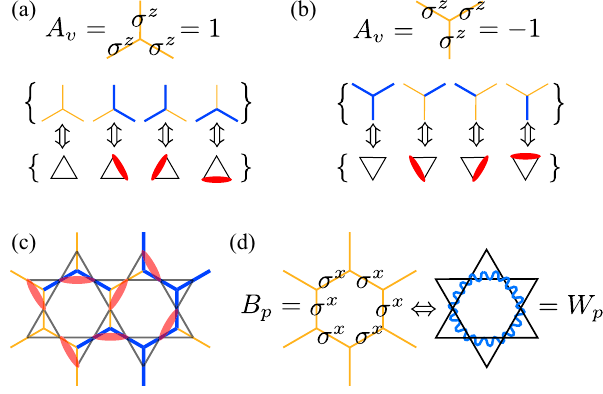
FIG. 8. Equivalence between kagom´e dimer model and honey- comb toric code. There is a local map between the Hilbert space of dimer coverings of the kagom´e lattice and odd loop states on the honeycomb lattice, by which we mean that (a) on the A 1 such that we have loop states (with sublattice we enforce A v ¼ σ z ¼ − 1 signifying a loop, shown in solid blue), but (b) on the B − 1 such that an odd number of strings terminate sublattice A v ¼ there. (c) Example of the local equivalence between a dimer state and such an odd loop state. (d) Usual plaquette operator B of the p toric code, which is equivalent to the dimer resonance W defined p in Eq. (10) under this local